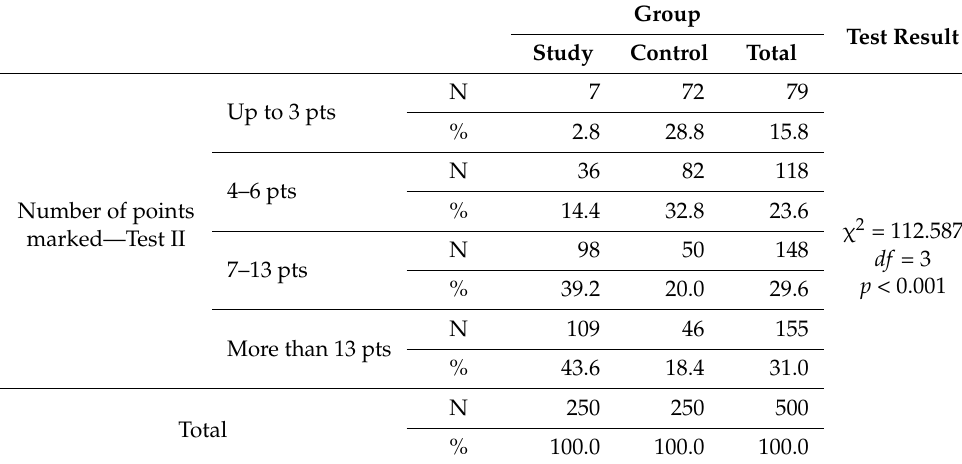
Table 6. Number of points subjected to breast examination—Test II.